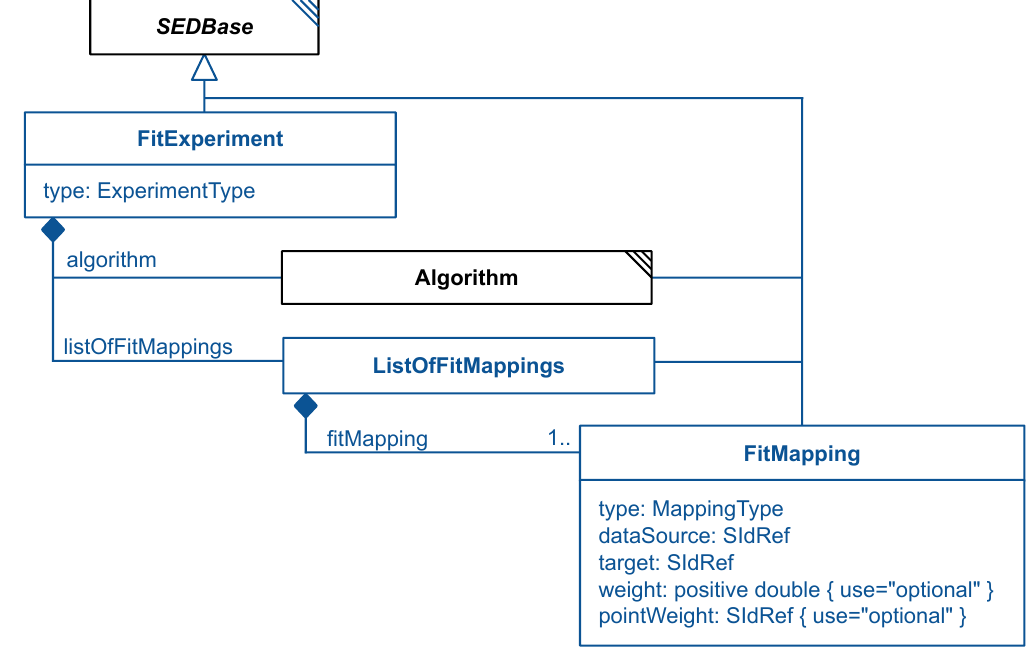
Figure 2.18: The SED-ML FitExperiment, ListOfFitMappings, and FitMappings